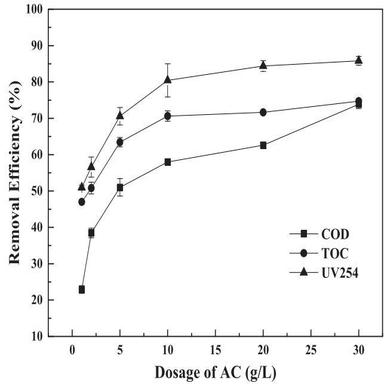
Removal efficiencies of COD, TOC and UV254 with different dosage of AC and Ca (OH)2.